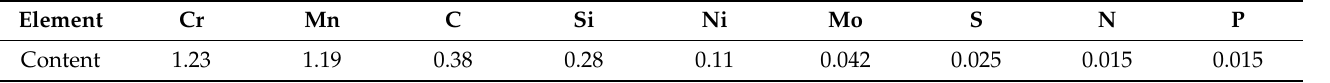
Table 1. Chemical compositions of the studied SAE 5137H steel